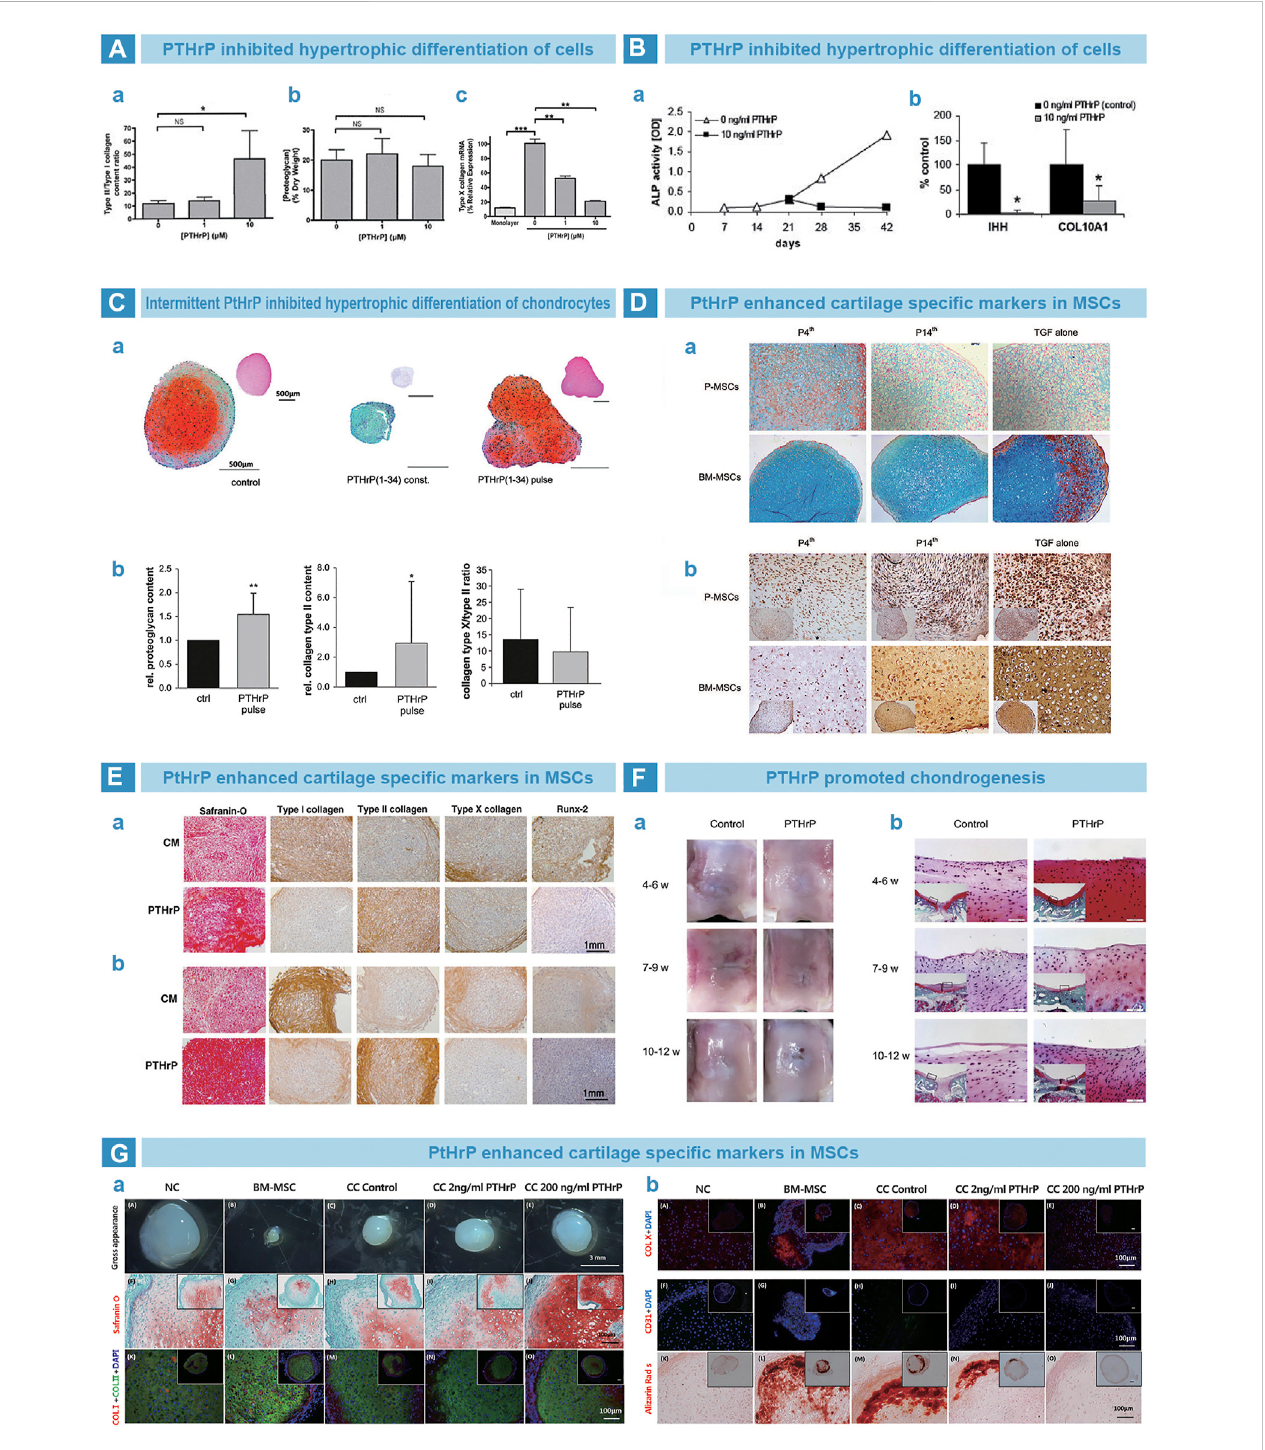
FIGURE 7 PTH-related peptide (PTHrP) in osteoarthritis. (A) . PTHrP prevented the hypertrophy of chondrocytes. Collagen quanti fi cation results that the content ratio of collagen type II to collagen type I was signi fi cantly improved by PTHrP (A) , while the proteoglycan exhibited no difference by DMMB assay (B) . However, the expression of collagen type X was signi fi cantly downregulated by PTHrP, as qPCR results (Ka fi enah et al., 2007). (B) . PTHrP inhibited the endochondral indexes of ALP activity and mRNA expression of Indian hedgehog and collagen type X (Fischer et al., 2010). (C) . Pulsative stimulation of PTHrP was performed on chondrocytes (A) . The deposition of proteoglycan and collagen type II was promoted (B) , and decreased expression trend of collagentypeXwasfound (C) (Fischer etal.,2014). (D) .SupplementedPTHrP fromfourthdaystrengthenedthecartilage matrixdepositionofperiostealMSCs and bone marrow MSCs by Alcian blue (A) , but suppressed the endochondral osteogenesis, as immunohistochemical (IHC) staining of collagen type X (B) (Rajagopal et al., 2021). (E) . PTHrP improved the chondrogenic matrix depositionof proteoglycan and collagen type II by Safranin-O staining and IHC staining (A) .However,themarkersofendochondralosteogenesiswereinhibited,suchascollagentypeI,collagentypeXandRunx-2byIHCstaining(Kimetal.,2008). (F) . The time window between 4 and 6 weeks for PTHrP injection bene fi ted the rat knee cartilage repair best, as the result of gross morphology (A) and Safranin-Ostaining (B) (Zhangetal.,2013). (G) .ImplantedcellpelletsthattreatedwithPTHrPshowedimprovedSafranin-Ostainingandanti-collagentypeI/II IF staining after 3 weeks (A) . Meanwhile, weakly positive stains of Alizarin Red S and anti-collagen type X/CD31 IF staining were found (B) (Anderson-Baron et al.,